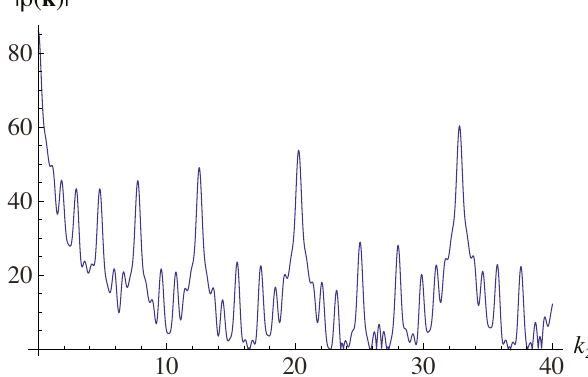
Figure 7. We show | ( k )| on the line k = (0, k 2 ), where the Fourier transform ( k ), given by Eq. (45) arises from the mass distribution (44). For the convergence factor a –| m | we have taken a = 1.1.